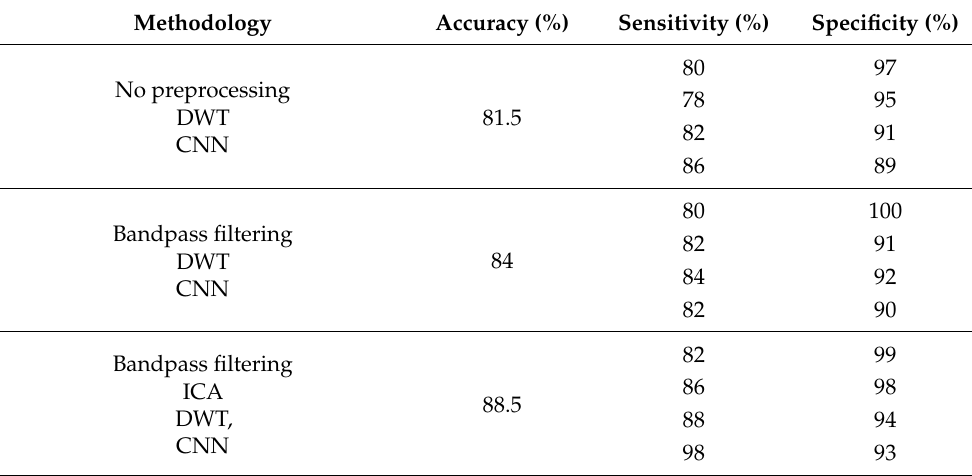
Table 1. Results obtained on AMIGOS dataset by varying different experimental